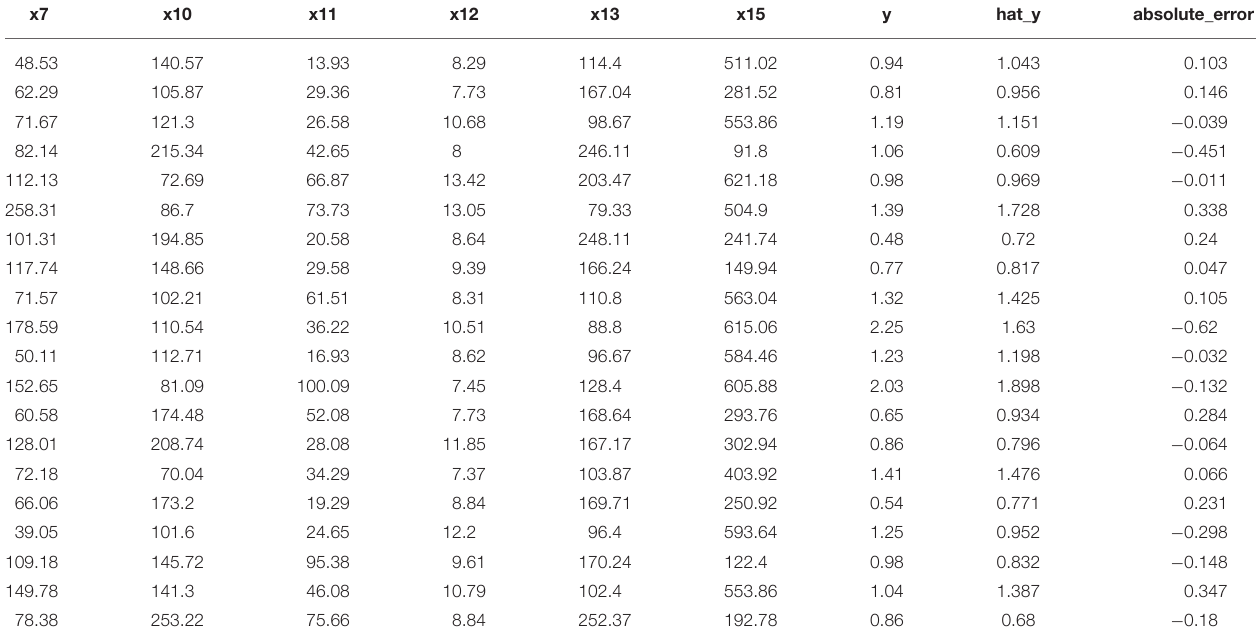
TABLE 3 | The results of the training set of the biomass and the key physiological/biochemical indicators.